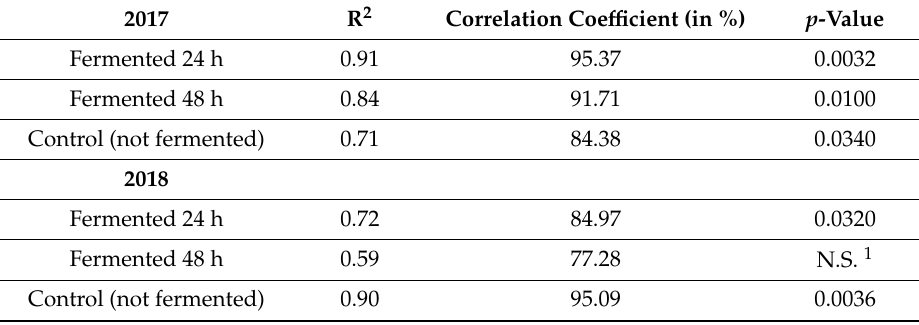
Table 4. The simple Pearson’s regression between antioxidant activity and total polyphenols in fireweed leaves for two experimental years 2017 and 2018.